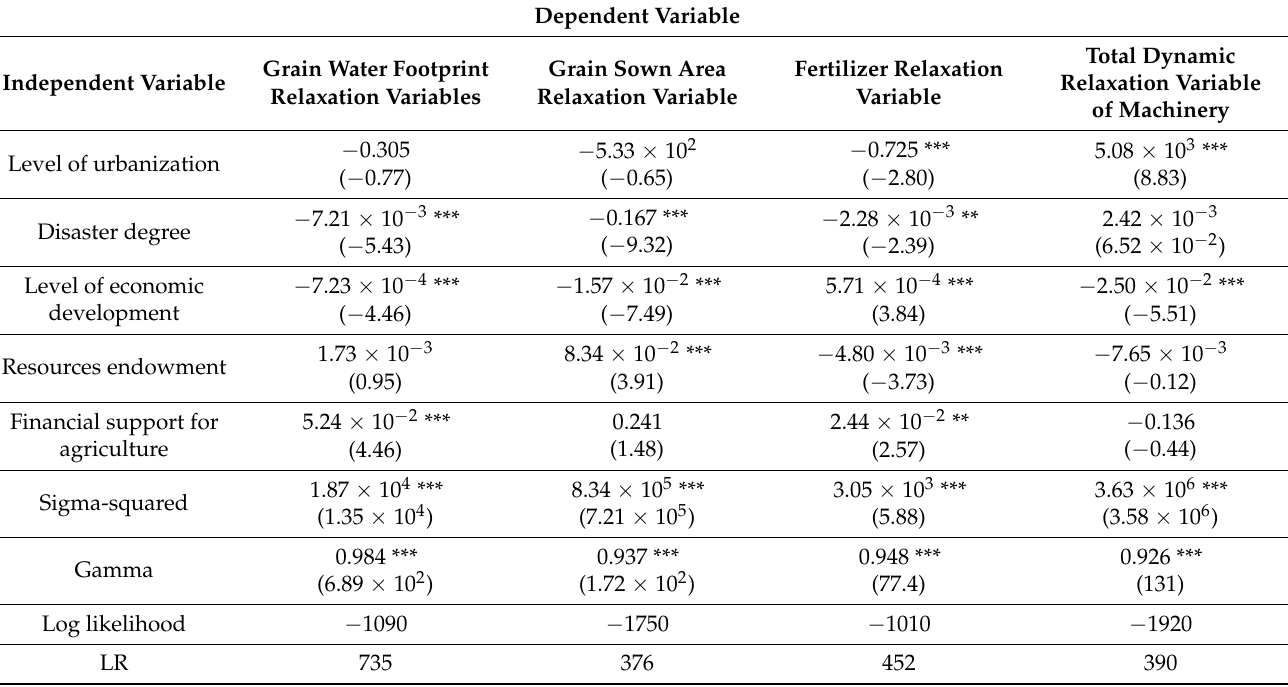
Table 2. Regression results of the second stage